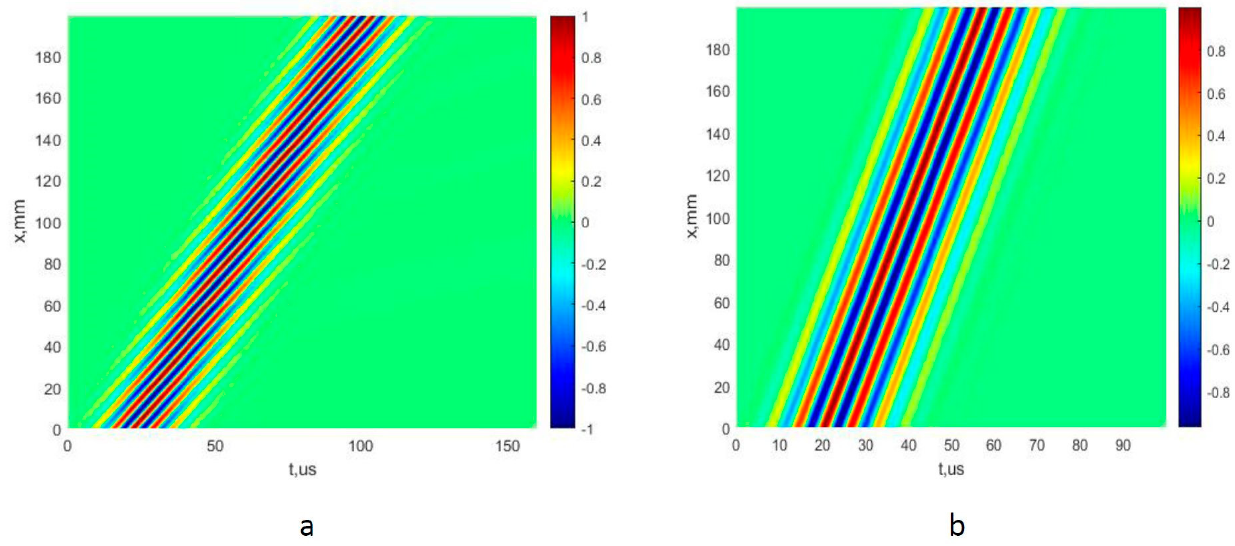
Figure 3. The B-scan images of the simulated A 0 ( a ) and S 0 ( b ) modes of Lamb waves, using a mathematical model.